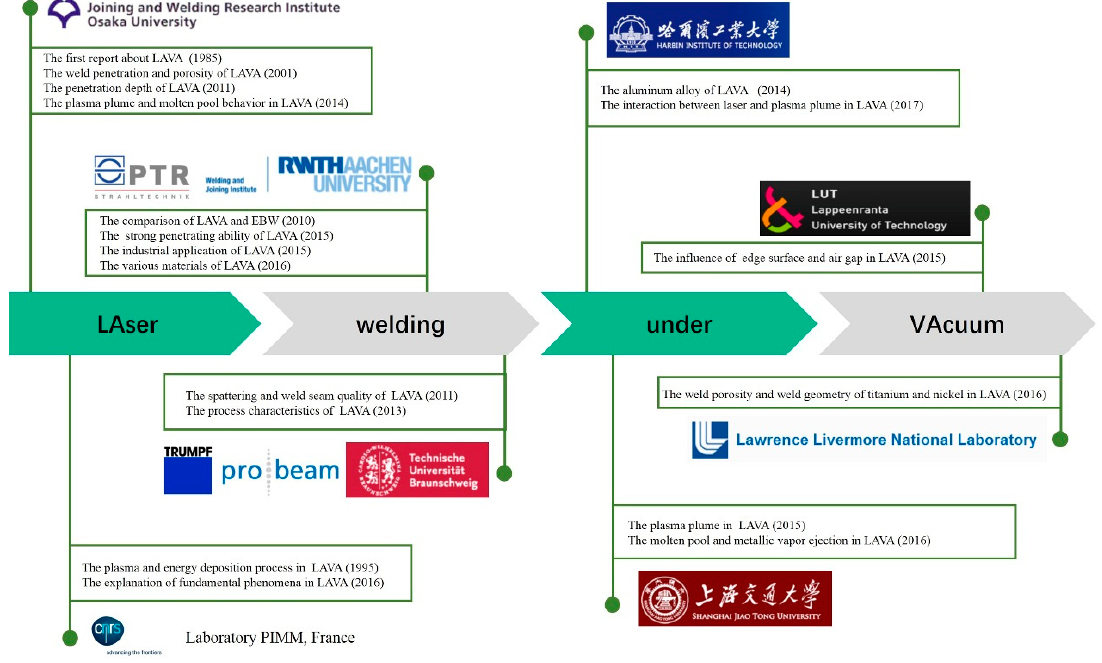
Figure 1. The research status of laser welding under vacuum.